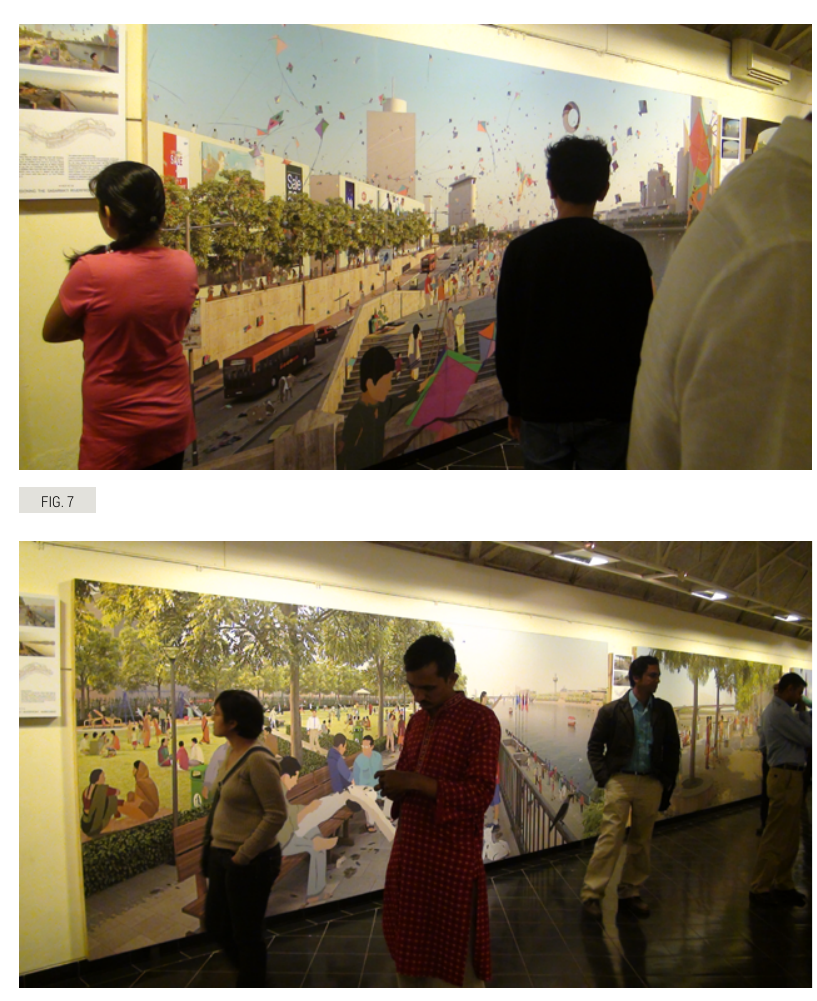
Fig. 7 and 8 Picture taken at the inauguration of the exhibition of the Sabarmati Riverfront Development Project at CEPT University on December 18, 2010. The visualizations show the nature of the public spaces imagined along the riverfront, e.g. gardens and promenades in a context of rapid real estate development (photo: Gloria Pessina,